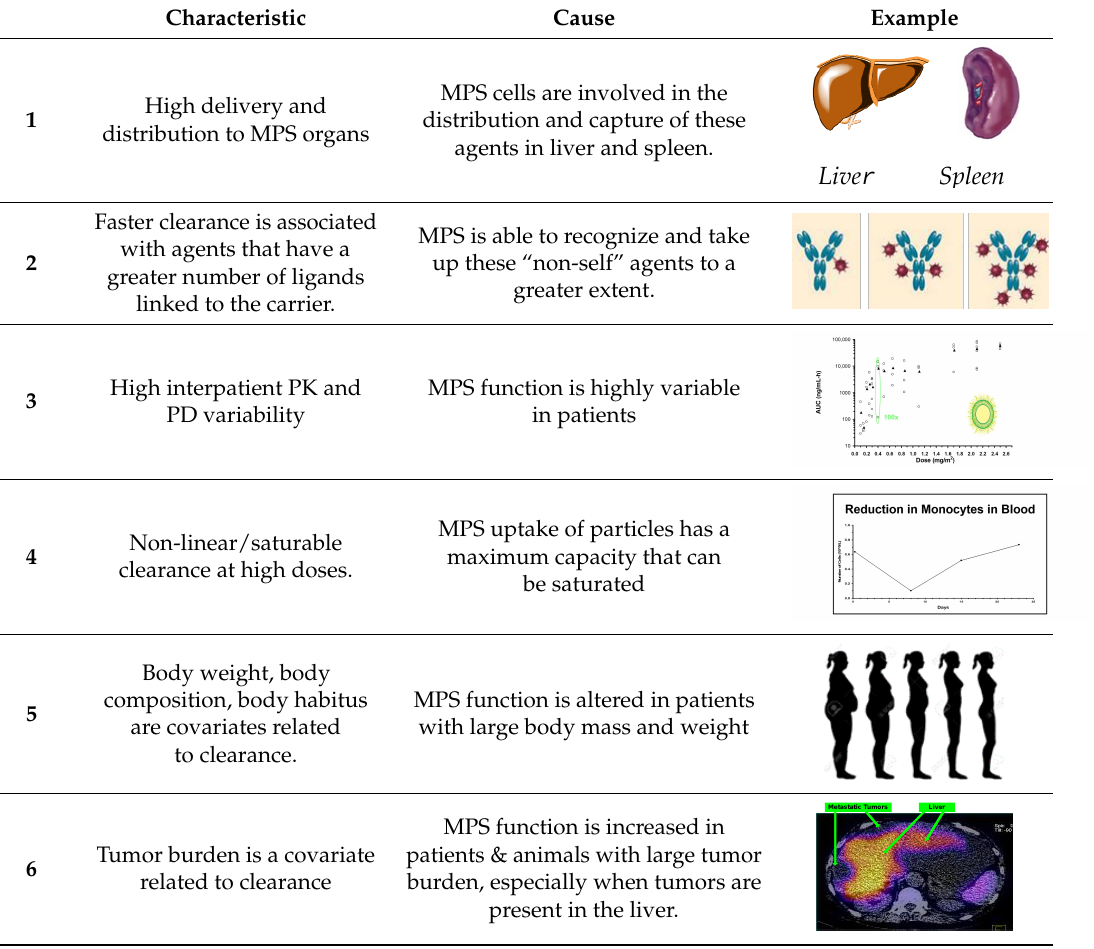
Table 2. Summary of pharmacokinetic (PK) and pharmacodynamic (PD) similarities for nanoparticles (NPs) and antibody–drug conjugates (ADCs) associated with the mononuclear phagocyte system (MPS) clearance.